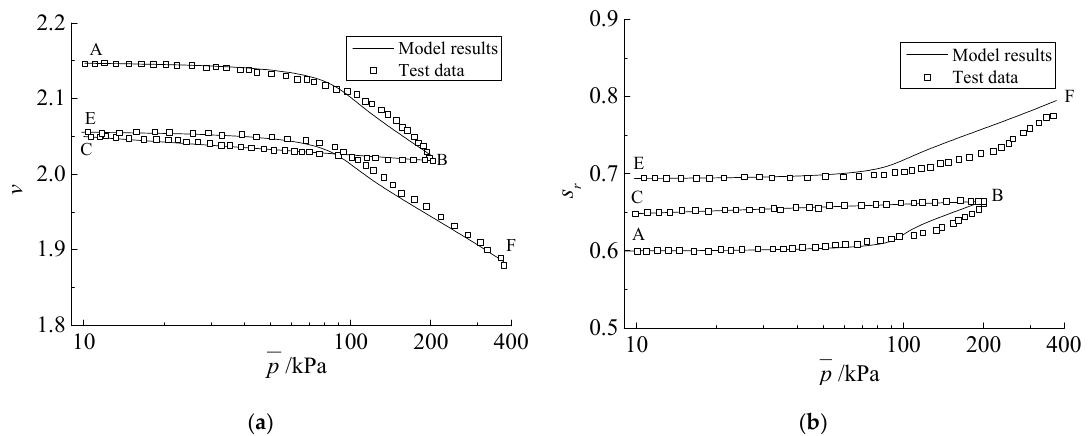
Figure 3. Comparison between modeling results and measured test data for Speswhite kaolin under isotropic loading and unloading: ( a ) specific volume; ( b ) degree of saturation.